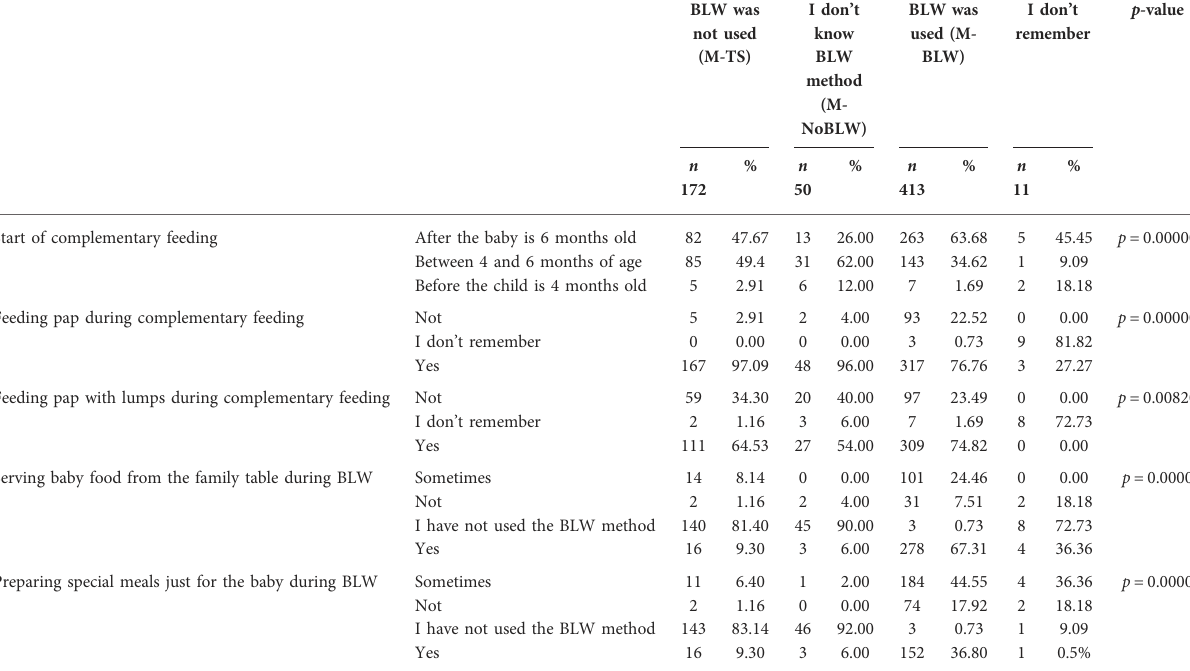
TABLE 4 Method of complementary feeding including the use of the BLW method in the study group of mothers and children ( N